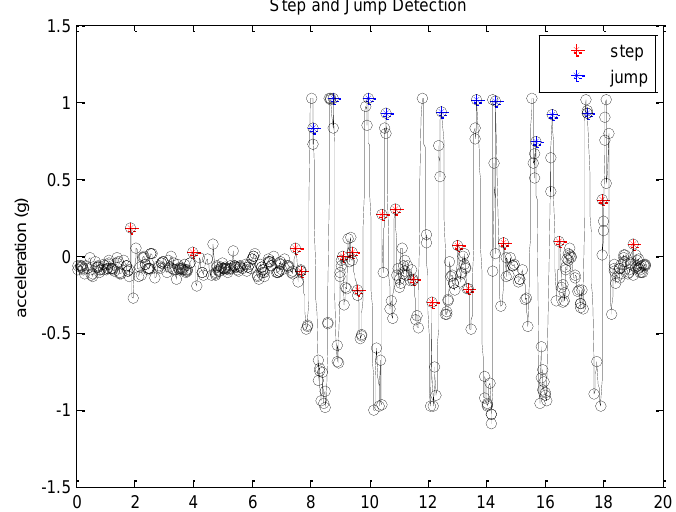
Figure 12. An example of step and jump detection from accelerometer data.